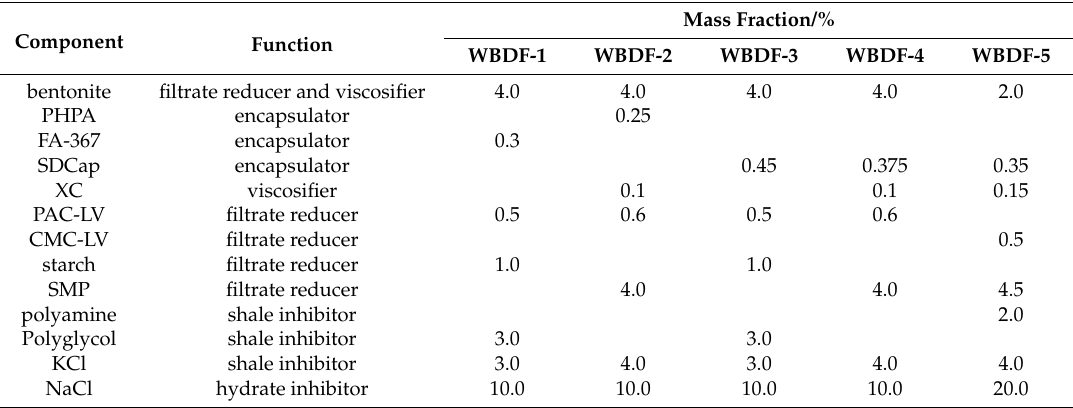
Table 1. Composition of the WBDFs (water-based drilling